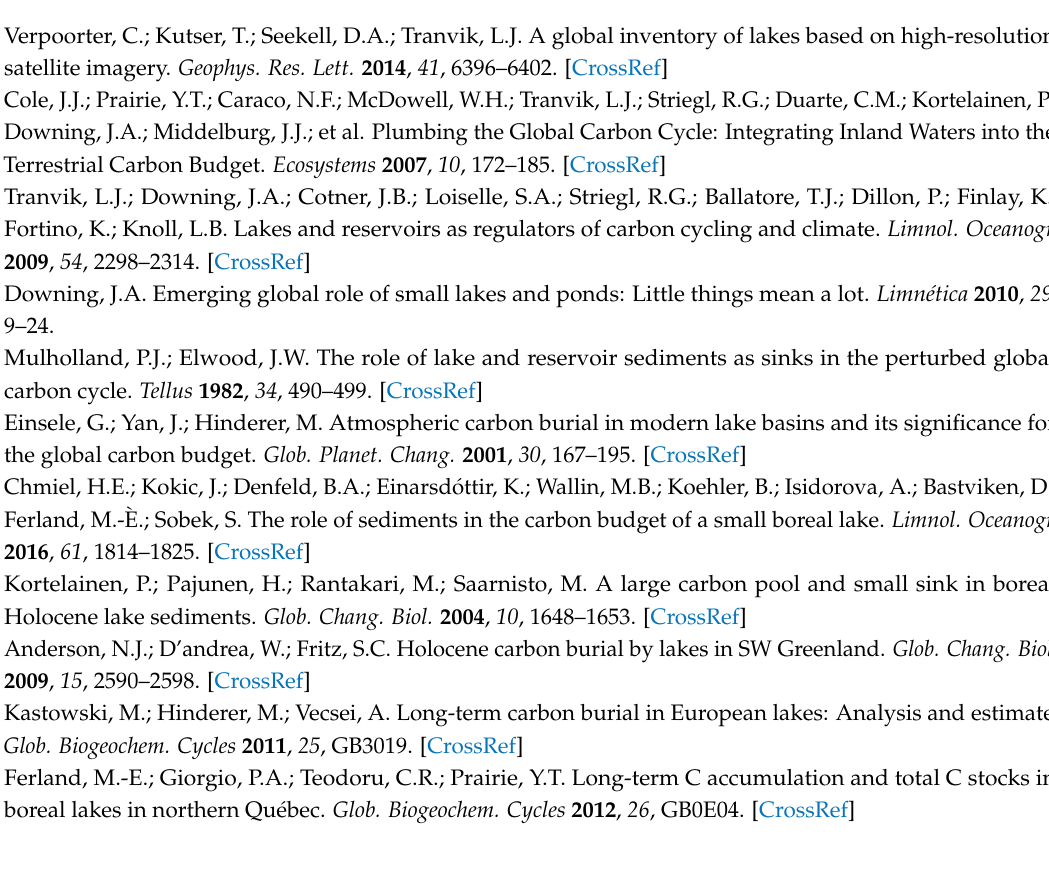
Table S1: Carbon Content of Cored Lakes; Table S2: Carbon Content of Lakes with Depths; Table S3: All Lakes Carbon